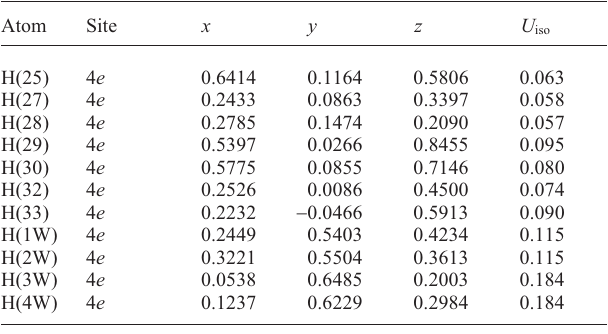
Table 3. Atomic coordinates and displacement parameters (in Å 2 )